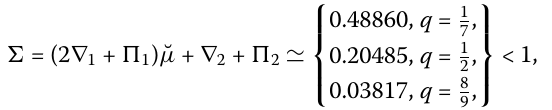
Table 2 Numerical results of ∇ 1 , ∇ 2 , (cid:14) 1 , and (cid:14) 2 for q = 1